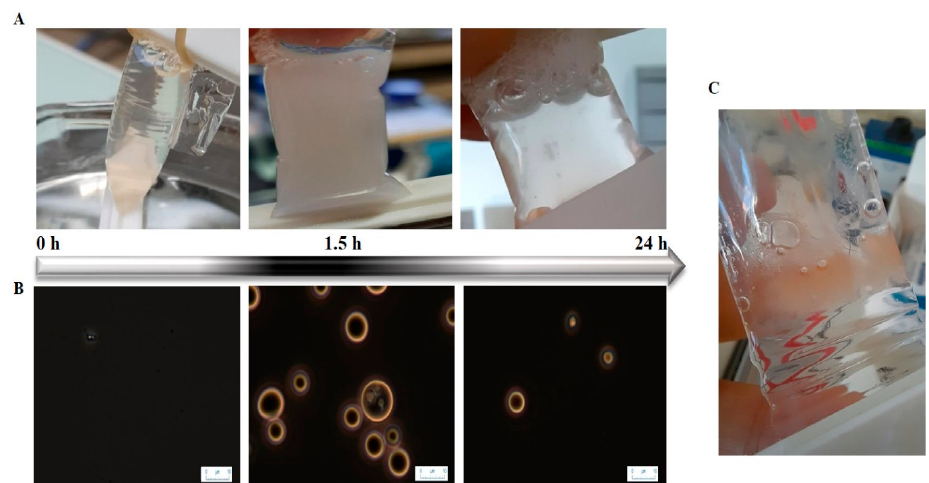
Figure 5. Appearance of lactoferrin– β -lactoglobulin coacervates during desalting protocol as a function of dialysis time for the initial salt concentration of 100 mM. ( A ): visual aspect inside the dialysis tube; ( B ): corresponding microscopic images showing the formation of coacervate droplets; ( C ): an image of the coacervates at the bottom of the dialysis tube at the end of the dialysis experiment. Dialysis was performed against 10 mM MES buffer at pH 5.5. Scale bar: 10 µm.